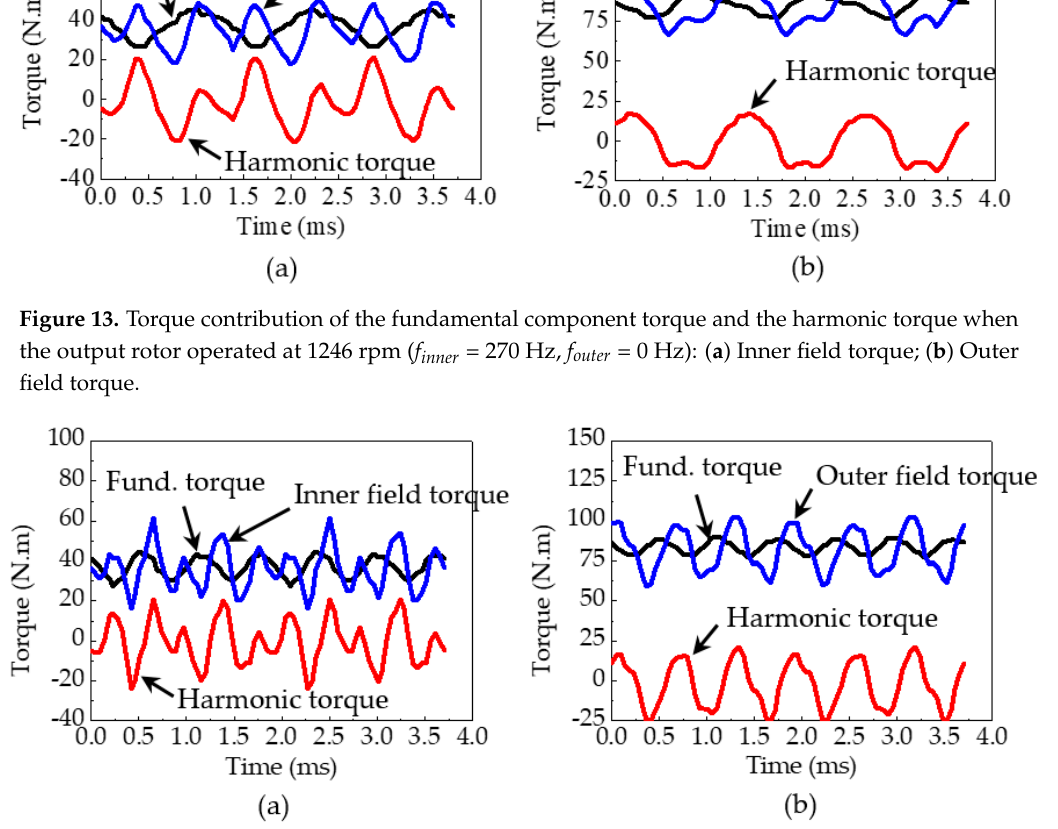
Figure 14. Torque contribution of the fundamental component torque and the harmonic torque when the output rotor operated at 2492 rpm ( f inner = 270 Hz, f outer = 270 Hz): ( a ) Inner field torque; ( b ) Outer field torque.